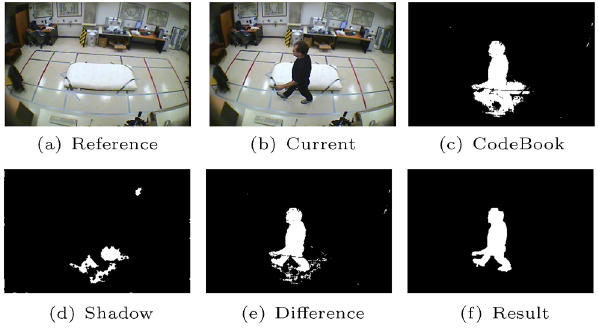
Fig. 4 Extracting a human from the background: (a) reference frame, (b) current frame, (c) CB result, (d) shadow detection, (e) difference between (c) and (d), (f) segmented human